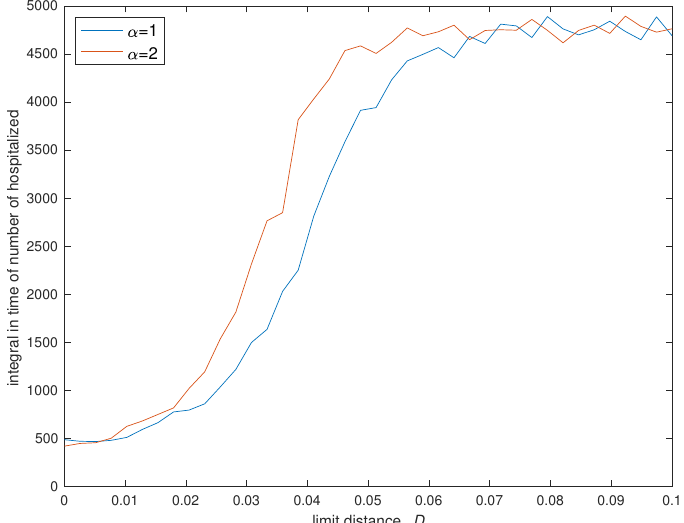
Figure 6. Variation of the integral in time of the number of hospitalized ( I 1 ) versus the social neighborhood D for α = { 1,2 } ( N = 500, n i = 50, δ = 0.1, p 1 = 0.1, p 2 = 0.9, p 3 = 0.7, p 4 = 0.05, p 5 = 0.02 and N h → ∞ ).